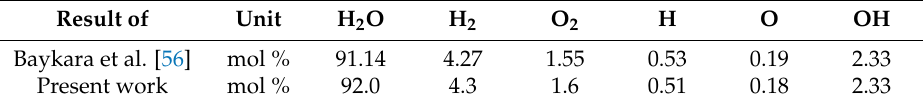
Table 2. Chemical composition of H 2 O at 2227 ◦ C at the pressure of 1 atm. Result of Unit H 2 O H 2 O 2 H O OH Baykara et al. [56] mol % 91.14 Present work mol %